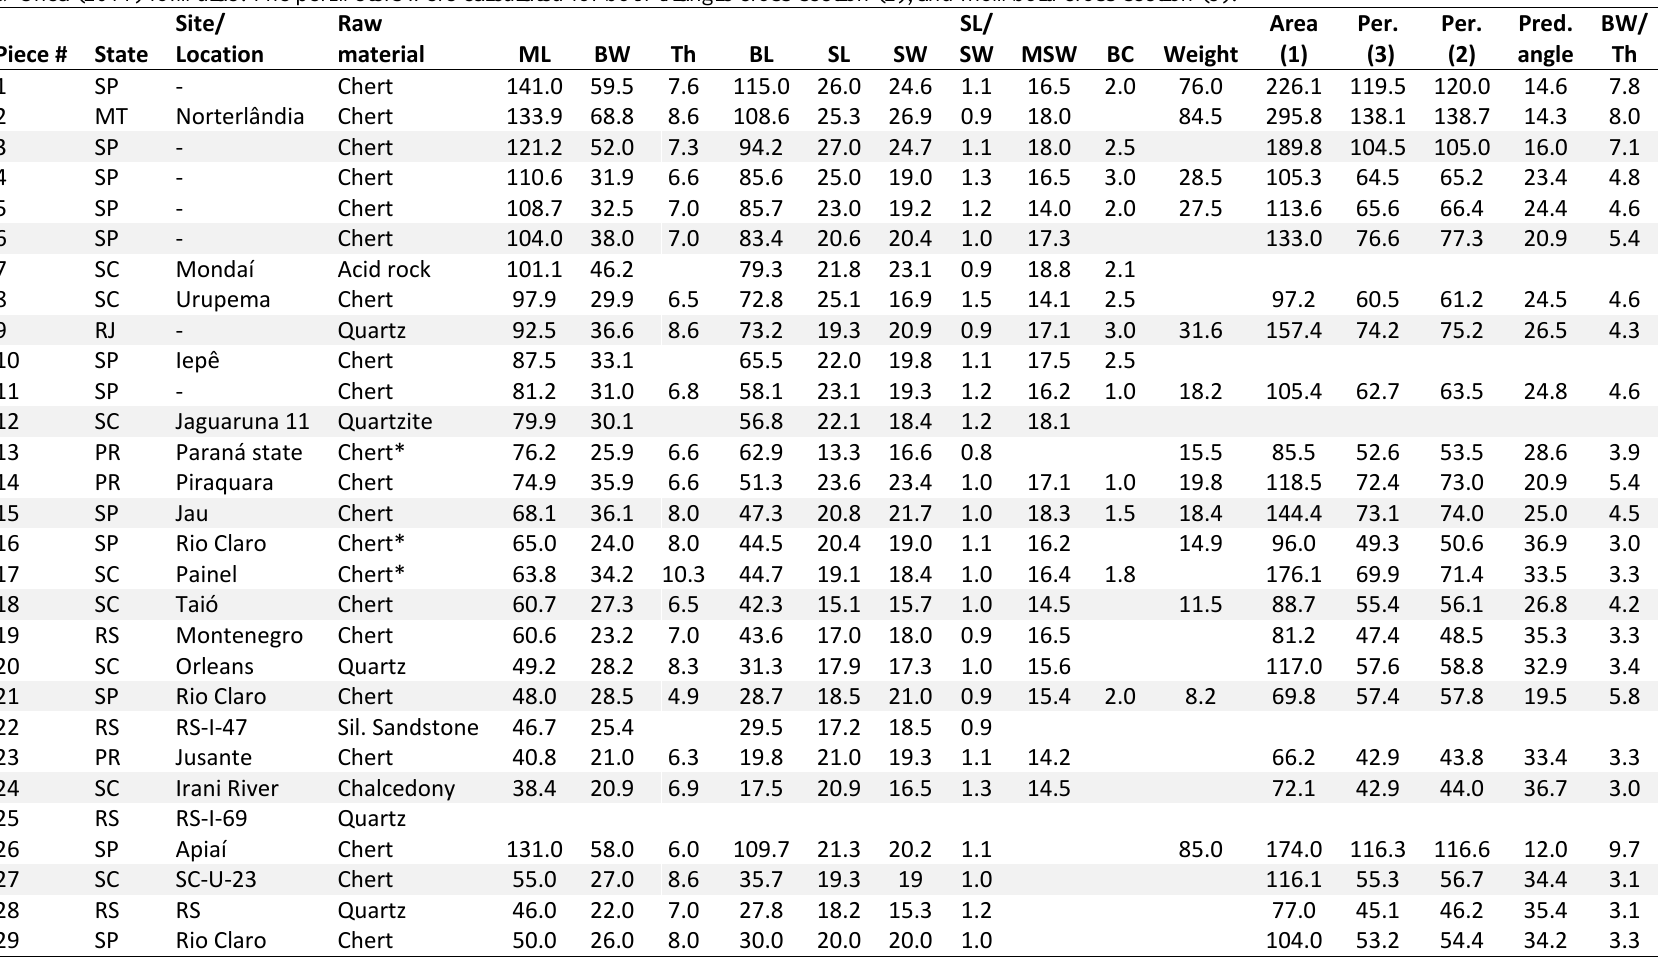
Table 1. Raw materials, weight, linear dimensions (regular font) and elaborated metric values (in bold) of the FPs included in this study. The map of the measurements can be seen in Supplementary file 2. ML: maximum length (or total length). BW: Blade width. Th: Thickness. BL: Blade length. SL: stem length. SW: stem width. SL/SW: ratio. MSW: Minimum stem width. BC: Basal concavity. *With chalcedony or opal inclusions. The width of the blades of pieces 1 and 3 are corrected from Loponte et al . (2016). In the piece #13 the maximum length and the stem measurements are estimated due to an oblique fracture. The cross-section area (1) and perimeters (2) (3) are based on Sisk & Shea (2011) formulae. The perimeters were calculated for both triangle cross-section (2), and rhomboid cross-section